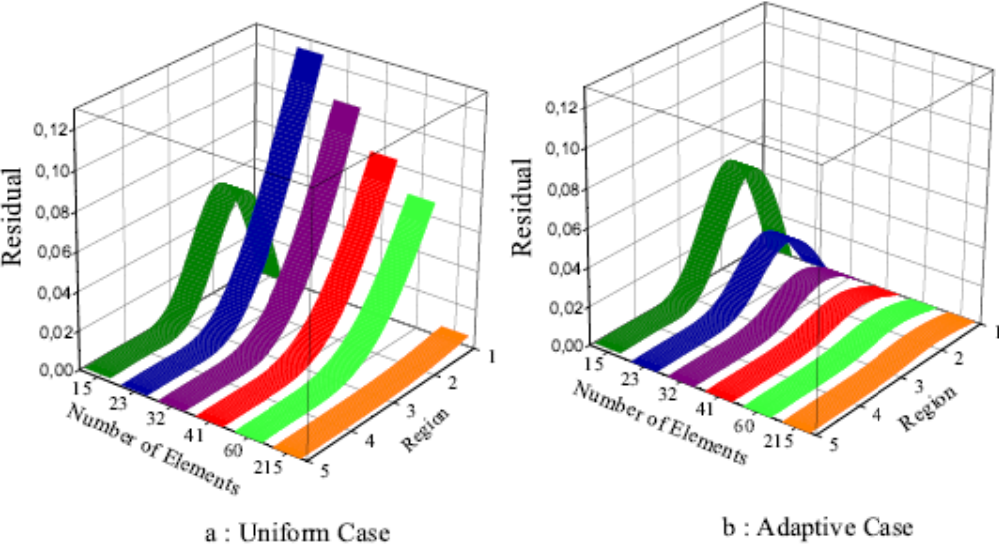
Figure 6. The effects of increasing the number of elements in ( a ) uniform meshes, ( b ) adaptive meshes. c.